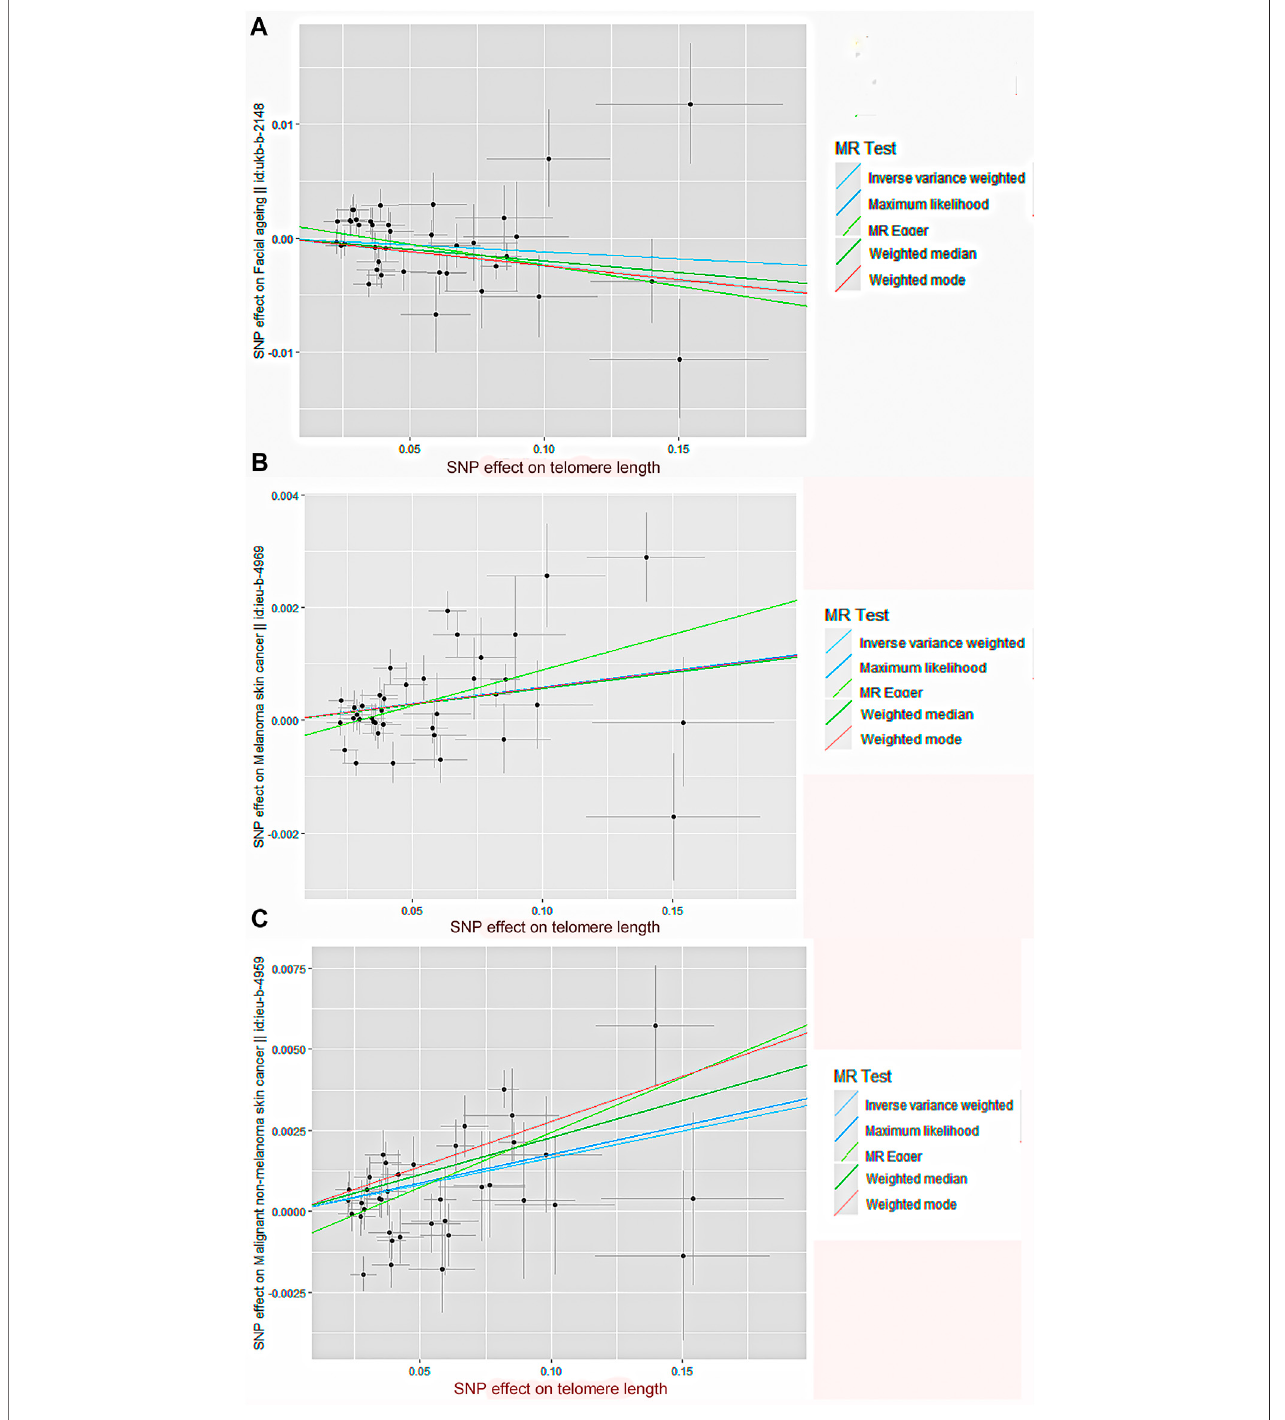
FIGURE 3 | Scatter plot of genetic causality between TL and skin aging and cancer using different MR methods. (A) Skin aging; (B) Melanoma; (C) NMSCs. The slope of the line represents the causality of the different methods. The dark blue line represents Maximum likelihood, the light green line represents MR Egger, the dark green line represents Weighted median, the light blue line represents IVW, and the red line represents Weighted mode.